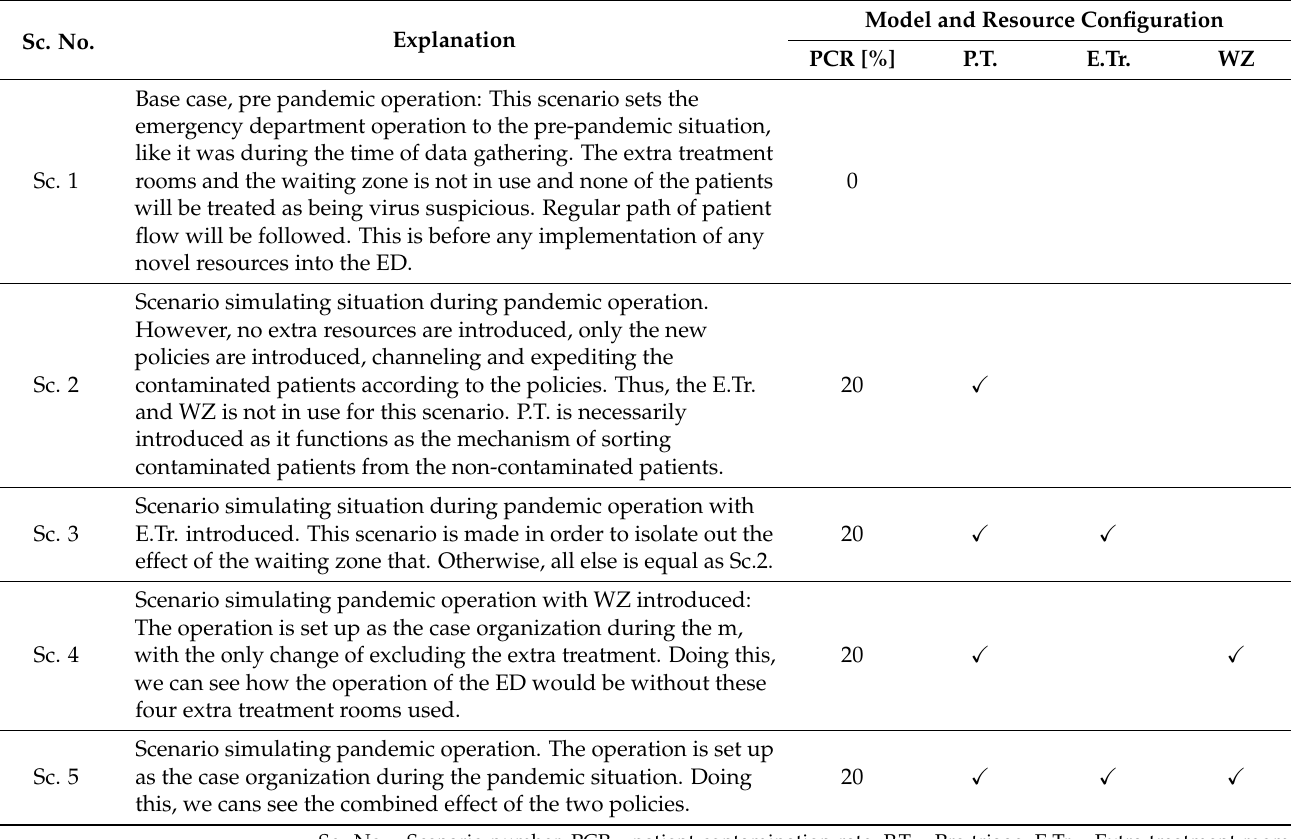
Table 1. Scenario descriptions and their respective configuration of resources and contamination. Sc. No. Explanation